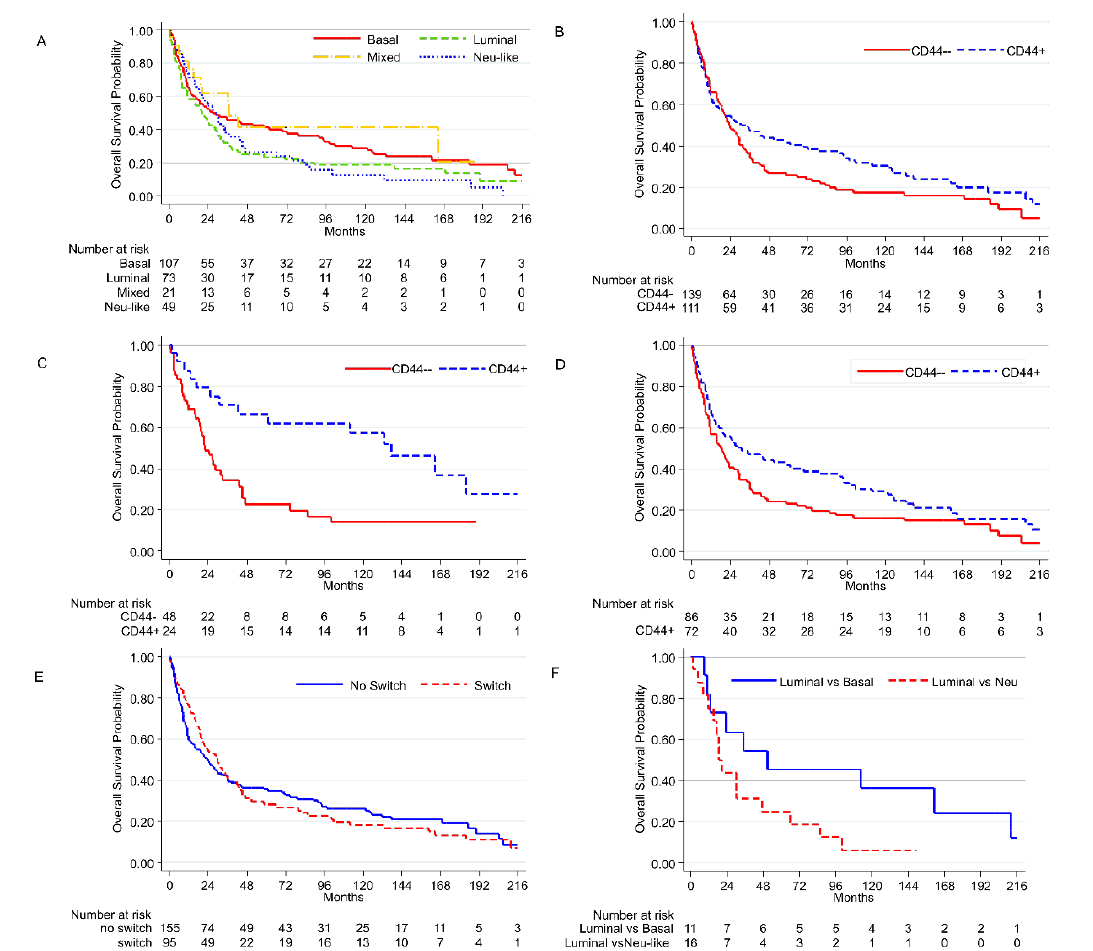
Figure 6. Distribution of mixed, basal, luminal, and neu-like phenotypes, OS ( p = 0.09) ( A ); CD44 expression in all tumors, OS ( p = 0.079) ( B ); CD44 expression in papillary UC, OS ( p = 0.008) ( C ); CD44 expression in CT naïve tumors, OS ( p = 0.04) ( D ); switched vs. non-switched tumors, OS ( p = 0.96) ( E ); switch towards basal patients vs. switch towards neu-like type patients, OS ( p = 0.027) ( F ).